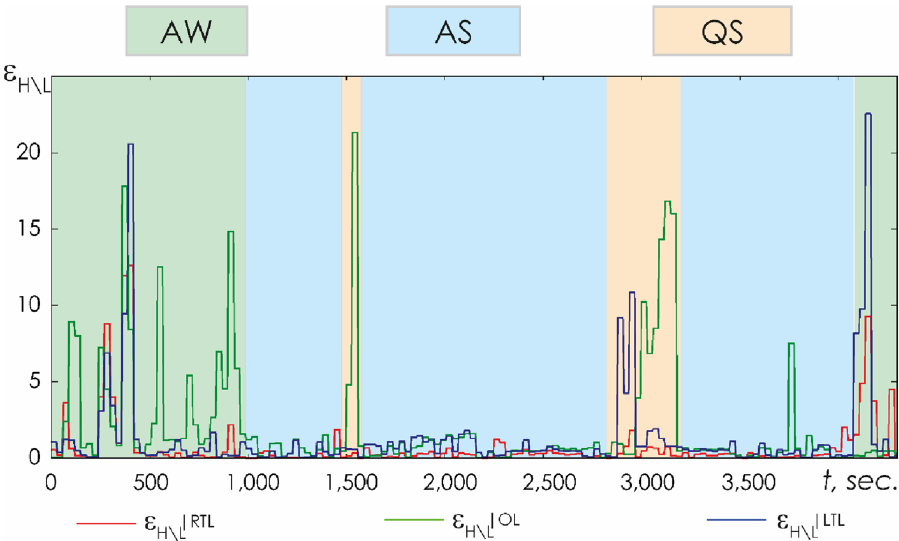
Figure 8. Relative energy calculation results for the right temporal (ε H\L |RTL, red line), occipital (ε H\L |OL, green line), and left temporal (ε H\L |LTL, blue line) lobes recorded during the second monitoring session in newborn # 42 from group I. The y-axis designates the value of the ratio (%); the x-axis represents time, t (s); the hypnogram for the newborn is presented as a color markup. Monitored stages are coded as follows: AW active wakefulness, AS active sleep, QS quiet